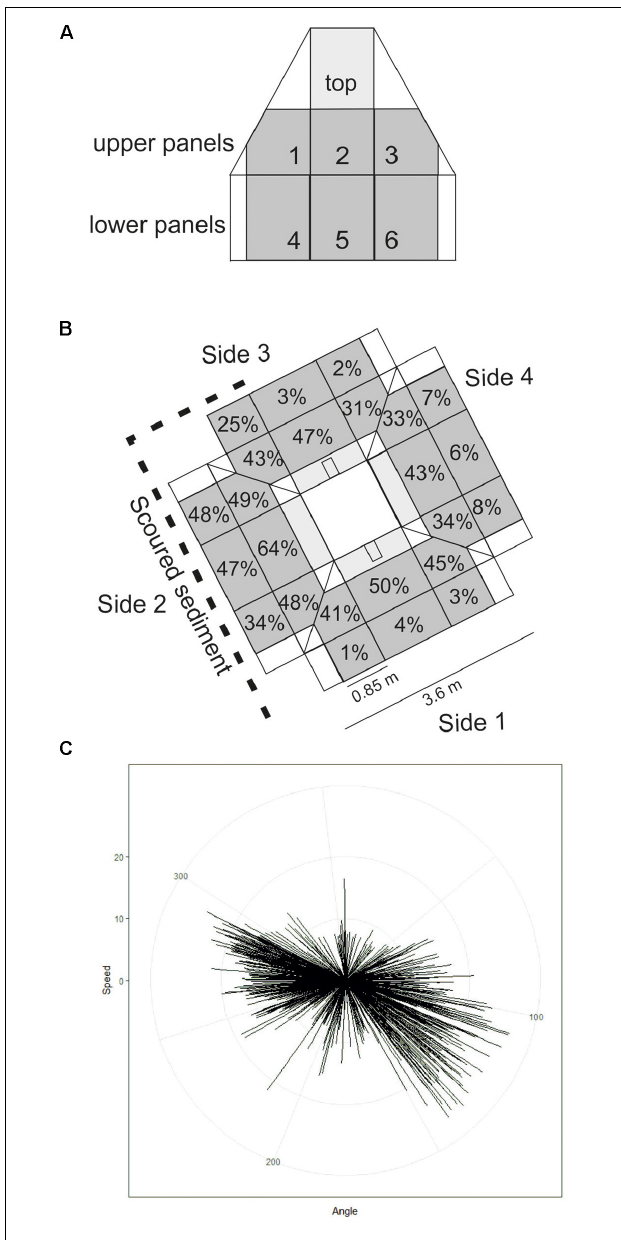
FIGURE 3 | (A) Representation of one side of Protective Structure A (not to scale). Panel numbers are labelled. Panels quantified in this study are grey in colour, those included in statistical analysis are darker grey. (B) Representation of the protective structure as it was orientated on the seafloor. Percentage cover by hydroid turf is indicated for each panel included in statistical analysis (diagram not to scale). (C) short-term seafloor current meter deployment with each line representing current speed and direction within a 5-min interval.